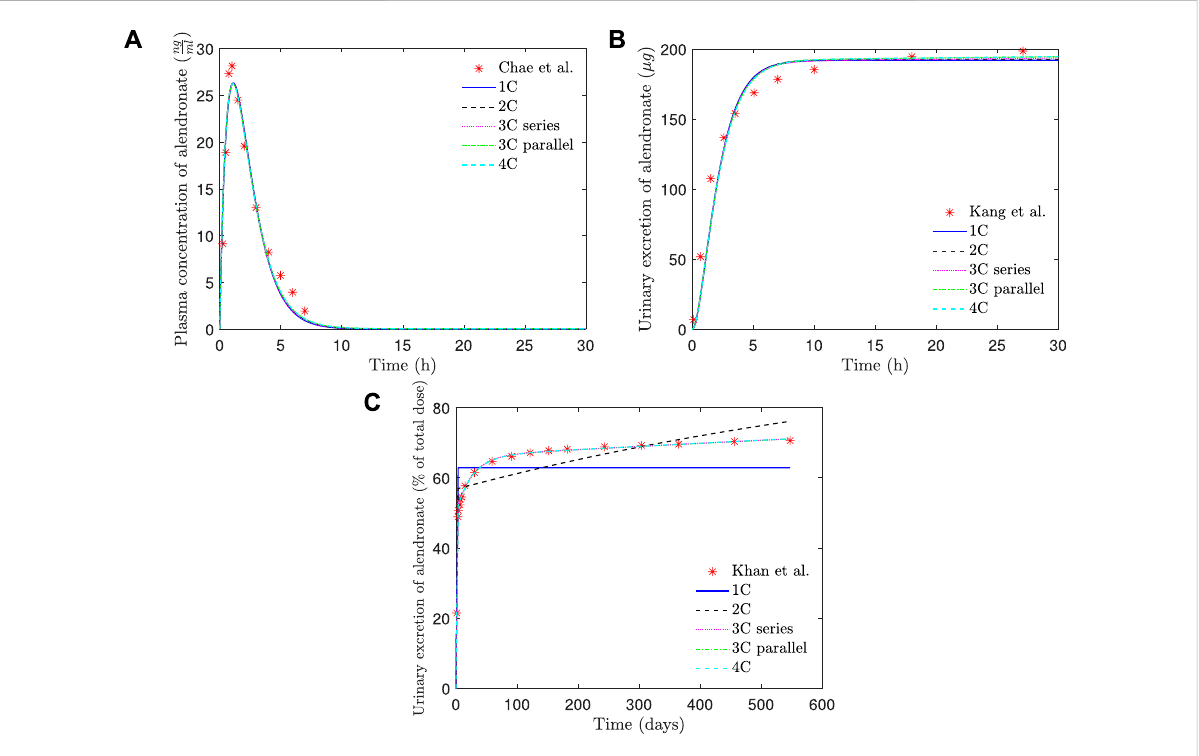
FIGURE 6 PK model results of alendronate: (A) plasma concentration versus time; (B) short-term urinary excretion vs. time; and (C) long-term urinary excretion vs. time. 1C: one-compartment model with two exits; 2C: two-compartment model; 3C series: three-compartment model “ in series ” ; 3C parallel: three-compartment model “ in parallel ” ; 4C: four-compartment